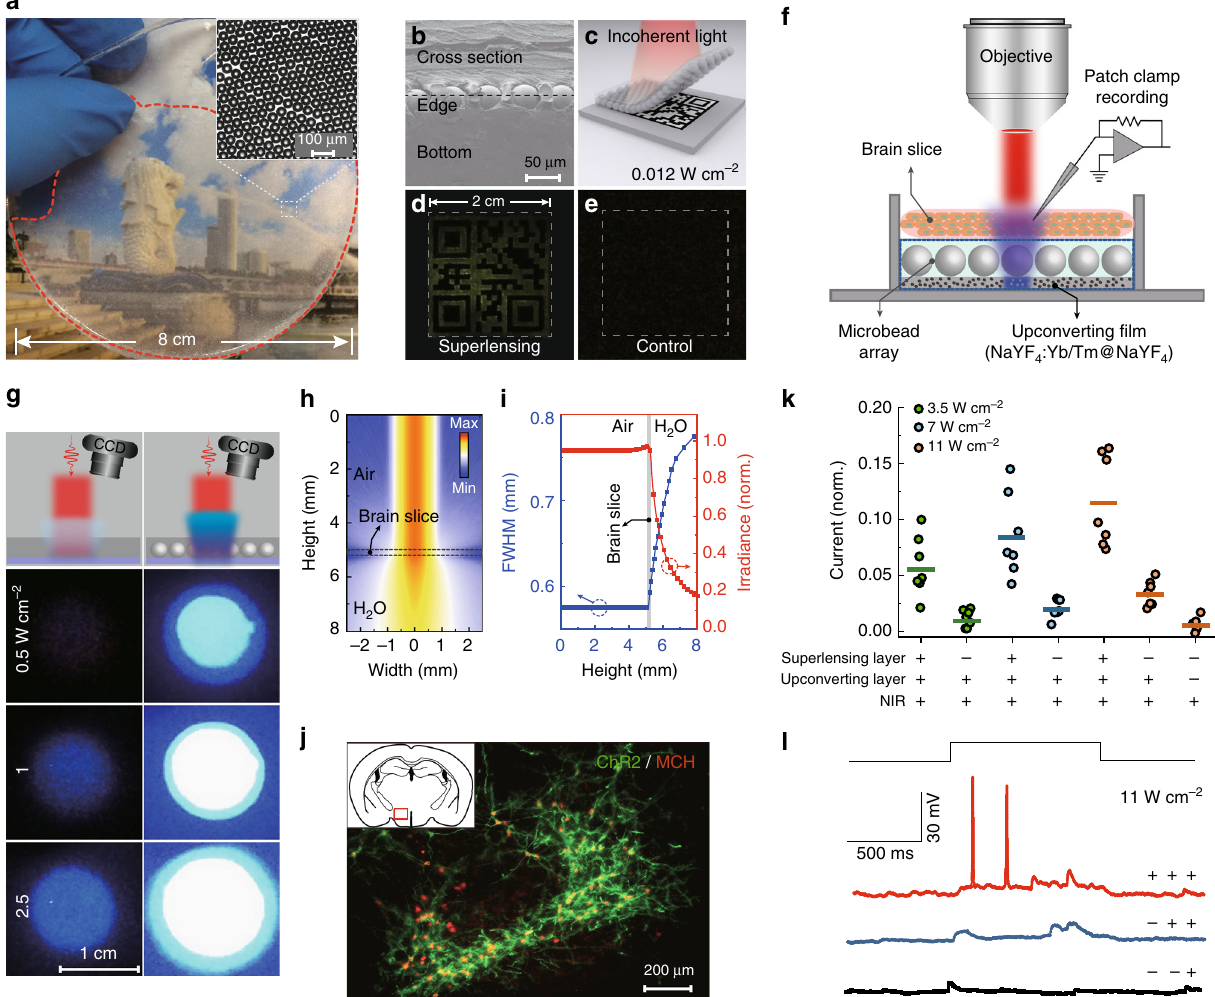
Fig. 4 Scale-up of dielectric superlensing for advanced applications. a Photographic image of a PDMS composite sheet comprising 50 μ m BaTiO 3 microbeads. Note that the distribution region of microbeads is circled with a red dashed curve. (Inset) Optical microscope image showing the ensemble of the microbeads used for making the planar sheet. b – e Demonstration of document security application using the composite sheet. The cross-section scanning electron microscopic image of composite sheet ( b ) and experimental design for upconversion-based encrypted barcoding ( c ). Photographic images, taken upon an incoherent light illumination, of an encrypted quick-response code with ( d ) and without ( e ) the composite sheet. f Schematic drawing illustrating the experimental setup for microbead-mediated optogenetics. Note that the setup consists of a microbead array and a thin layer of NaYF 4 :Yb/Tm@NaYF 4 UCNPs. g Experimental setup and photographic images of the UCNP/PDMS layer (left panel) and the microbead/UCNP composite chip (right panel), recorded upon 980 nm excitation with varied power densities. h, i Monte Carlo simulation of NIR light (980 nm) attenuation and scattering of a brain slice (~300 μ m thick). Cross-sectional view of the light intensity distribution of a collimated beam before and after penetration through the brain slice ( h ). Variation of the full width at half maximum (FWHM) and the irradiance of the light beam along the penetration path ( i ). j Fluorescence imaging of MCH neurons exclusively expressing ChR2 fused with eYFP (green) in the lateral hypothalamus. k Voltage-clamp tracing data showing the NIR/ upconversion light-induced ion currents through the membranes of MCH neurons in an acute brain slice in response to 500-ms NIR stimulation at various intensities (* p = 5.83 × 10 − 4 ). Source data are provided as a Source Data fi le. l Comparison of action potential fi ring evoking capability of different PDMS chips on NIR illumination using current-clamp traces from MCH neurons in response to 1-s of NIR illumination at a power density of 11 W cm − 2 . Here, these three + / − symbols represent the presence/absence of the dielectric superlensing layer, PDMS upconverting layer, and NIR